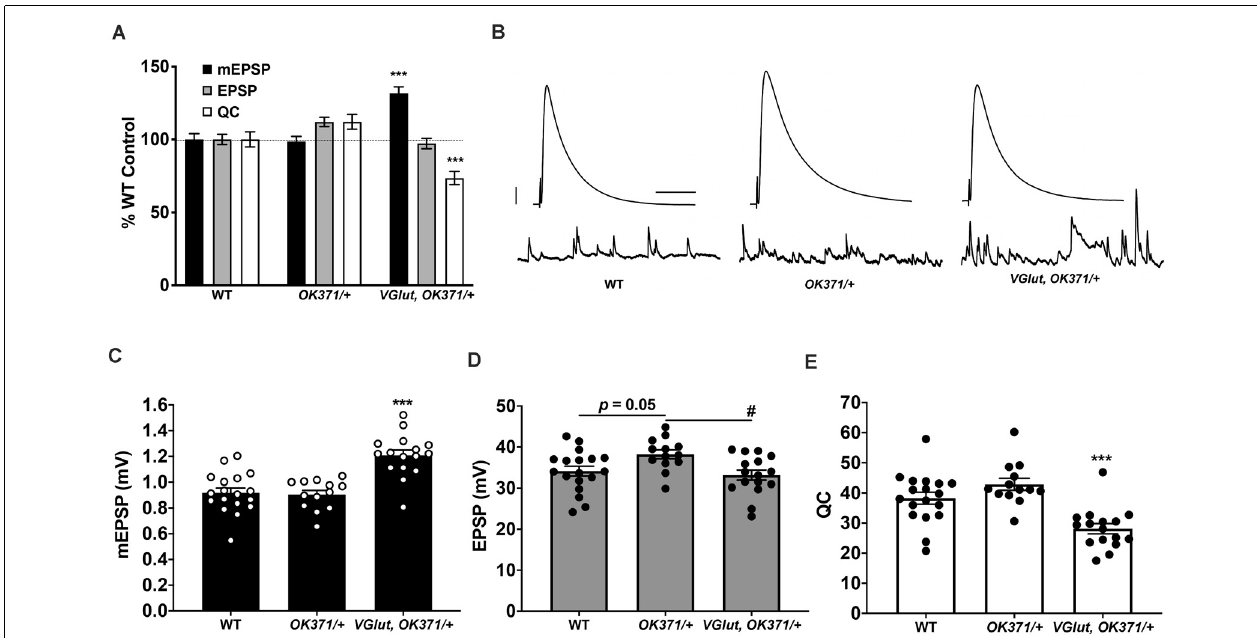
FIGURE 1 | Presynaptic homeostatic depression (PHD) works successfully with a recombinant line of OK371-Gal4 and UAS-VGlut . (A) Neuromuscular junction (NMJ) electrophysiological data for miniature excitatory postsynaptic potentials (mEPSP), excitatory postsynaptic potentials (EPSP), and quantal content (QC). Data are normalized to wild-type (WT; w 1118 ) values. VGlut, OK371/+ NMJs have increased mEPSP but normal EPSP because of decreased QC, indicative of successful PHD (*** p < 0.001 vs. WT by one-way ANOVA with Tukey’s post-hoc ). (B) Representative electrophysiological traces. Large traces are EPSPs; small traces are mEPSPs. Scale bars for EPSPs (mEPSPs) are 5 mV (1 mV) and 50 ms (1,000 ms). (C) Raw data for mEPSPs. (D) Raw data for EPSPs. (E) Raw data for QC. For (C–E) , bars are averages and error bars are ± SEM. *** p < 0.001 vs. WT or vs. OK371/+ ; # p < 0.05 vs. OK371/+ ; analyses by one-way ANOVA with